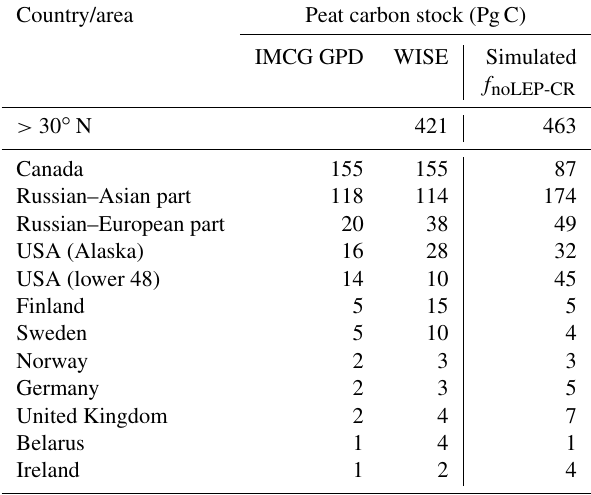
Table 4. Observed and simulated northern peatland C; countries are sorted in descending order according to the estimate of IMCG